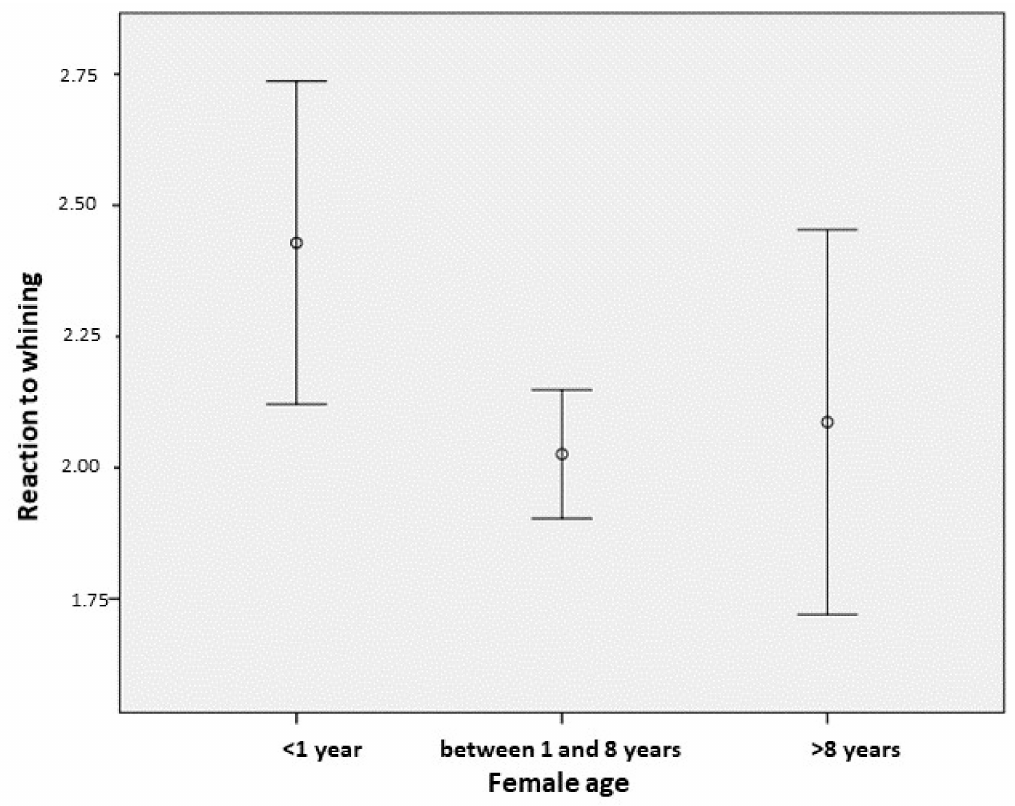
Figure 2. Association between the female dogs’ age (1 = younger than one year; 2 = adult; 3 = older than 8 years) and the intensity of their reaction to the puppies’ whining (mean ± 95% CI).